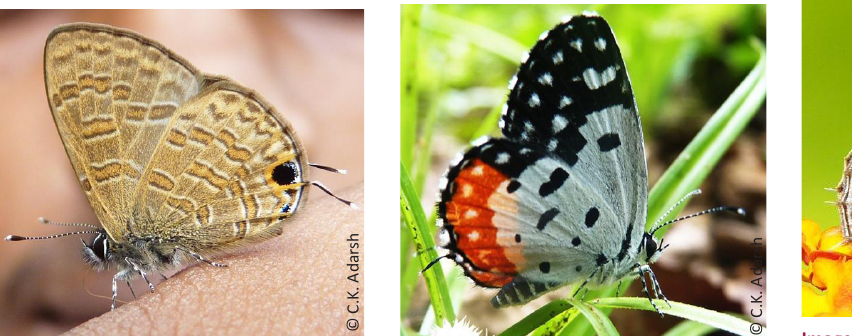
Image 77. Anthene lycaenina Pointed Ciliate